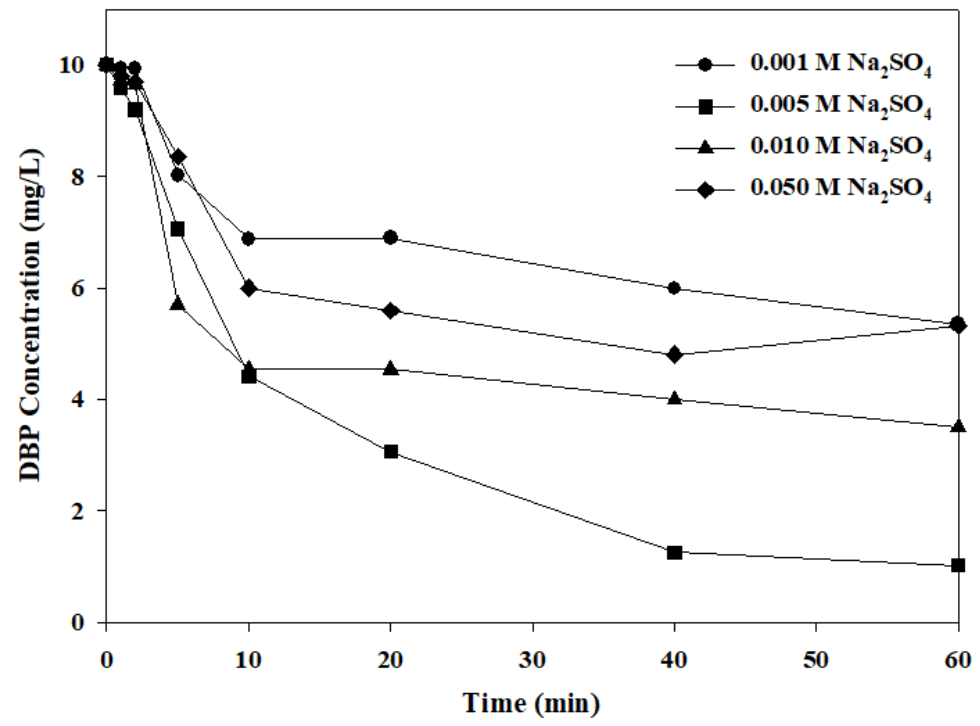
Figure 3. The variation of DBP concentration with different electrolyte concentrations.